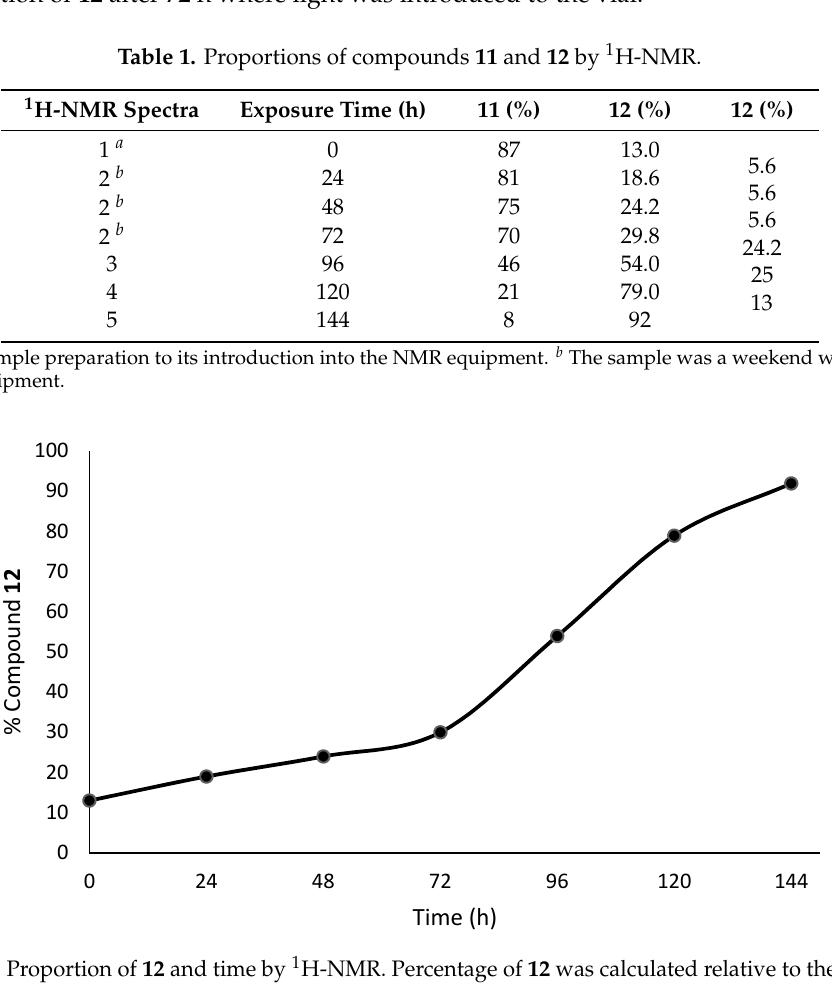
Figure 5 . Thin layer chromatography (hexane:AcOEt, 8:2) of Rx) in N 2 atmosphere and without light; compound 12 for reference.